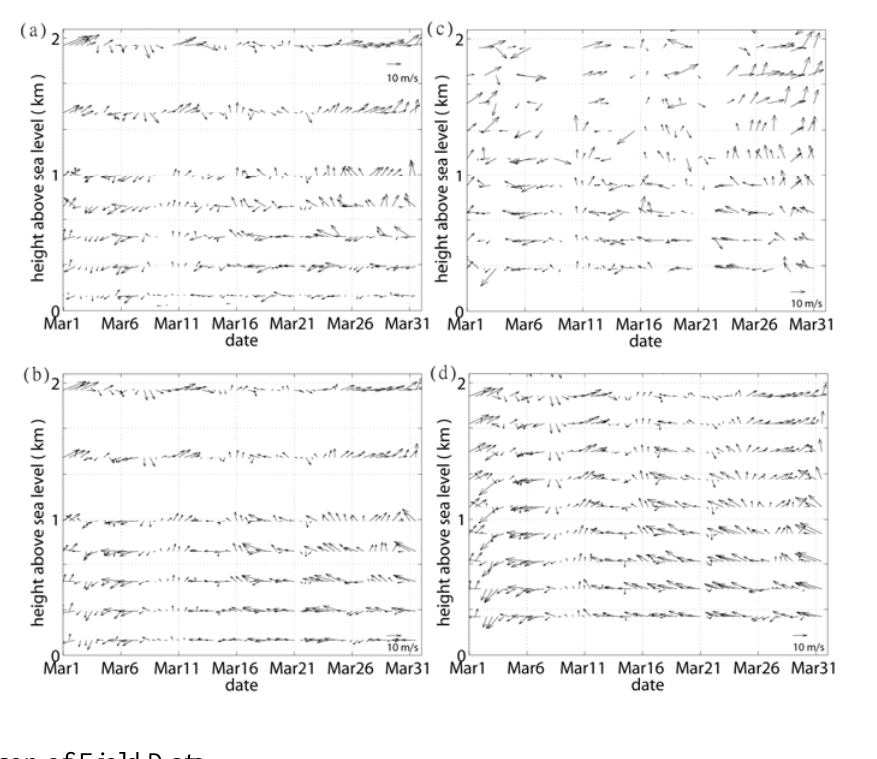
Figure 4. Comparisons of vertical wind fields. (a) King’s Park upper air sounding data (data available at every 12 hours UTC00 and UTC12) and (b) corresponding time CALMET model results at King’s Park; (c) Sham Shui Po wind profiler data (data available at every 12 hours UTC00 and UTC12) and (d) corresponding time CALMET model results at Sham Shui